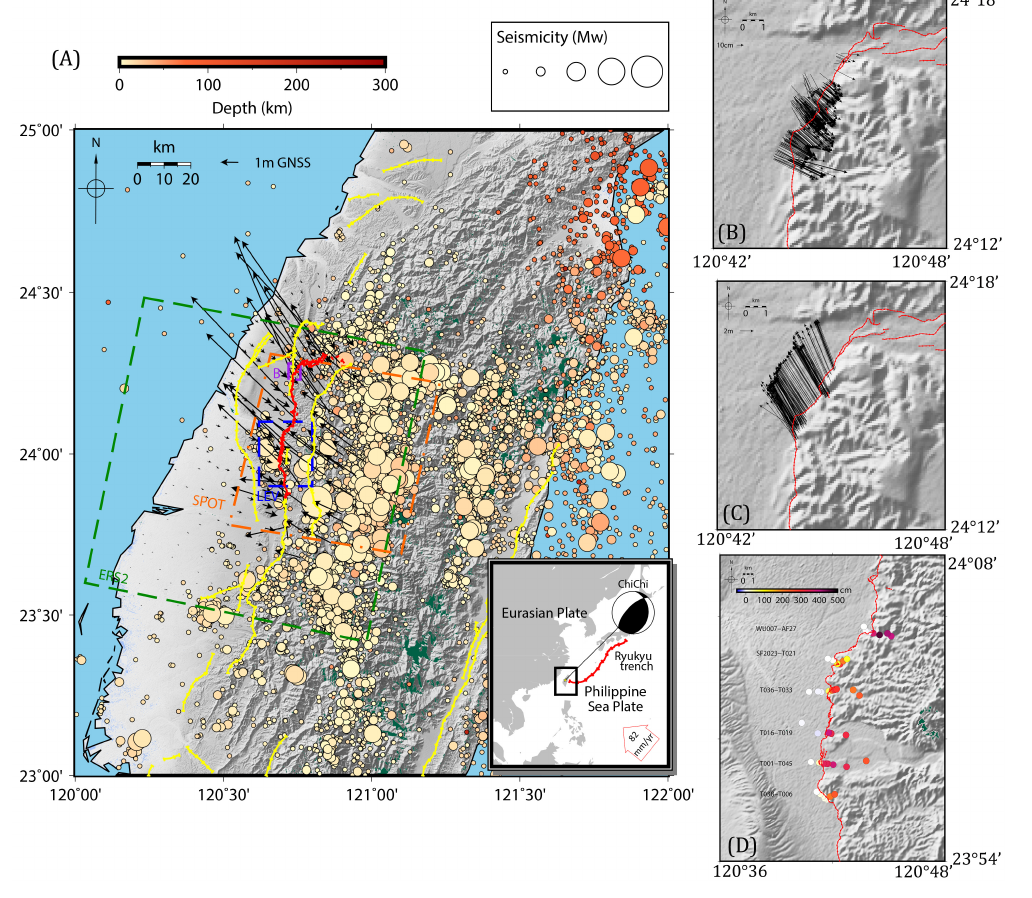
Figure 1. ( A ) Geodynamic map of Taiwan. The Chelungpu thrust fault is shown in red (National Taiwan University) and the other faults in yellow (National Taiwan University). Focal mechanism of the Chi-Chi earthquake on the inset map (USGS: 23.772 ◦ N 120.982 ◦ E). Seismicity (from 1998 to 2000, source National Taiwan University) over Taiwan. GPS displacement vectors ([9]) shown by black arrows. Green dashed box shows the location of the ERS-2 scenes from descending track 232, orange dashed box shows the location of the SPOT satellite images used in this study. The purple dashed box is the location of the benchmark data, results are presented in ( B ) for the footwall displacements and in ( C ) for the hanging-wall displacements (notice the different scale). Finally, the blue dashed box is the location of the levelling data, results are presented in ( D